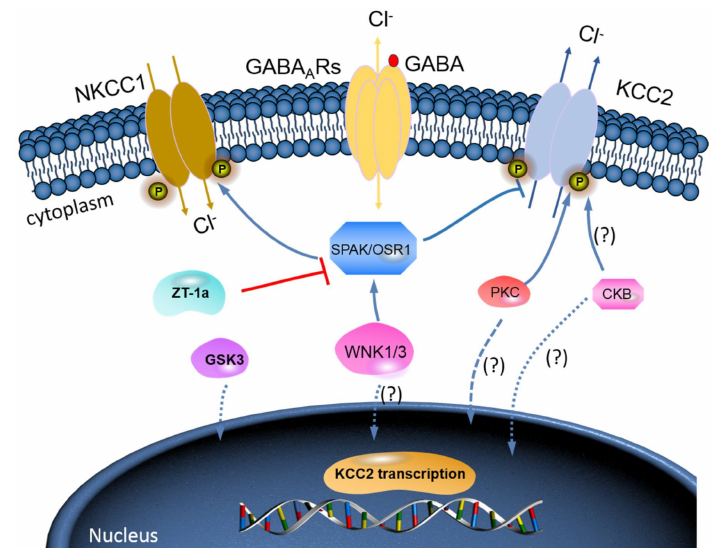
Figure 3. A novel strategy to facilitate neuronal Cl − extrusion and E GABA by coincident NKCC1 inhibition and KCC2 activation by inhibiting the WNK-SPAK / OSR1 kinases. Mammalian neurons that are challenged with multiple neuropsychiatric conditions (such as seizures, neuropathic pain, spasticity, schizophrenia, and others) are usually driven by hyperexcitable circuits, intraneuronal Cl − ([Cl − ] i ) levels are elevated due to increased NKCC1 activity, and / or decreased KCC2 activity, promoting GABA A R-mediated membrane depolarization and excitation. In healthy mature neurons, [Cl − ] i is low due to the opposite activity profile of the CCCs, promoting GABA A R-mediated hyperpolarization, which is critical for the proper balance of excitation–inhibition in neuronal circuits. WNK-SPAK / OSR1 inhibition, via the coincident e ff ects of NKCC1 inhibition and KCC2 activation (the main Cl − extrusion mechanism in neurons), might be a potent way of facilitating neuronal Cl − extrusion to restore ionic inhibition in diseases that are characterized by disordered Cl − homeostasis and GABA disinhibition. ZT-1a, a novel molecular compound, can specifically inhibit SPAK signalling pathway, thus interfering SPAK regulation of GABA signalling via NKCC1 inhibition and KCC2 activation [86]. Activation of protein kinase C (PKC) and brain-type creatine kinase (CKB) are likely to increase KCC2 cell surface expression, but the mechanisms involved are still